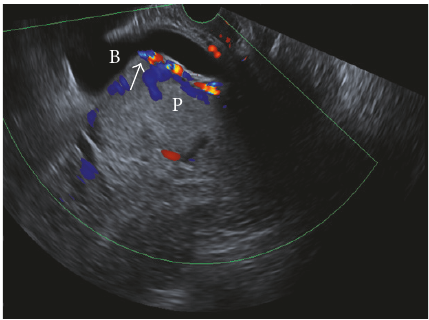
Figure 2: Large dilated vessels (arrowed) in the placental bed (P), possibly extending into bladder